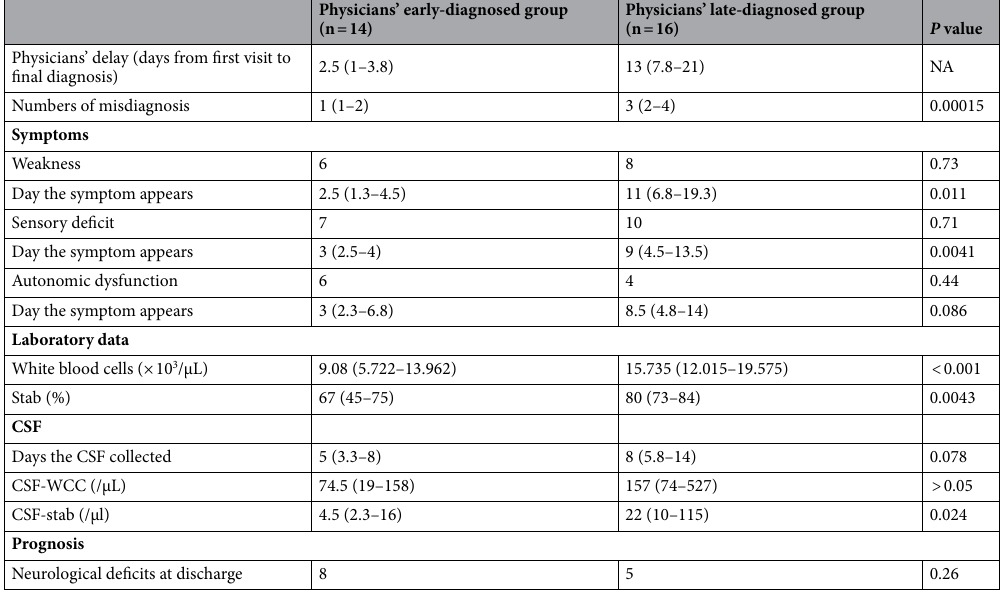
Table 3. Clinical parameters of the physician early-diagnosed and late-diagnosed groups. Numbers in parentheses denote interquartile ranges. CSF cerebrospinal fluids, ICU intensive care unit, EDSS expanded disability status score, NA not applicable.